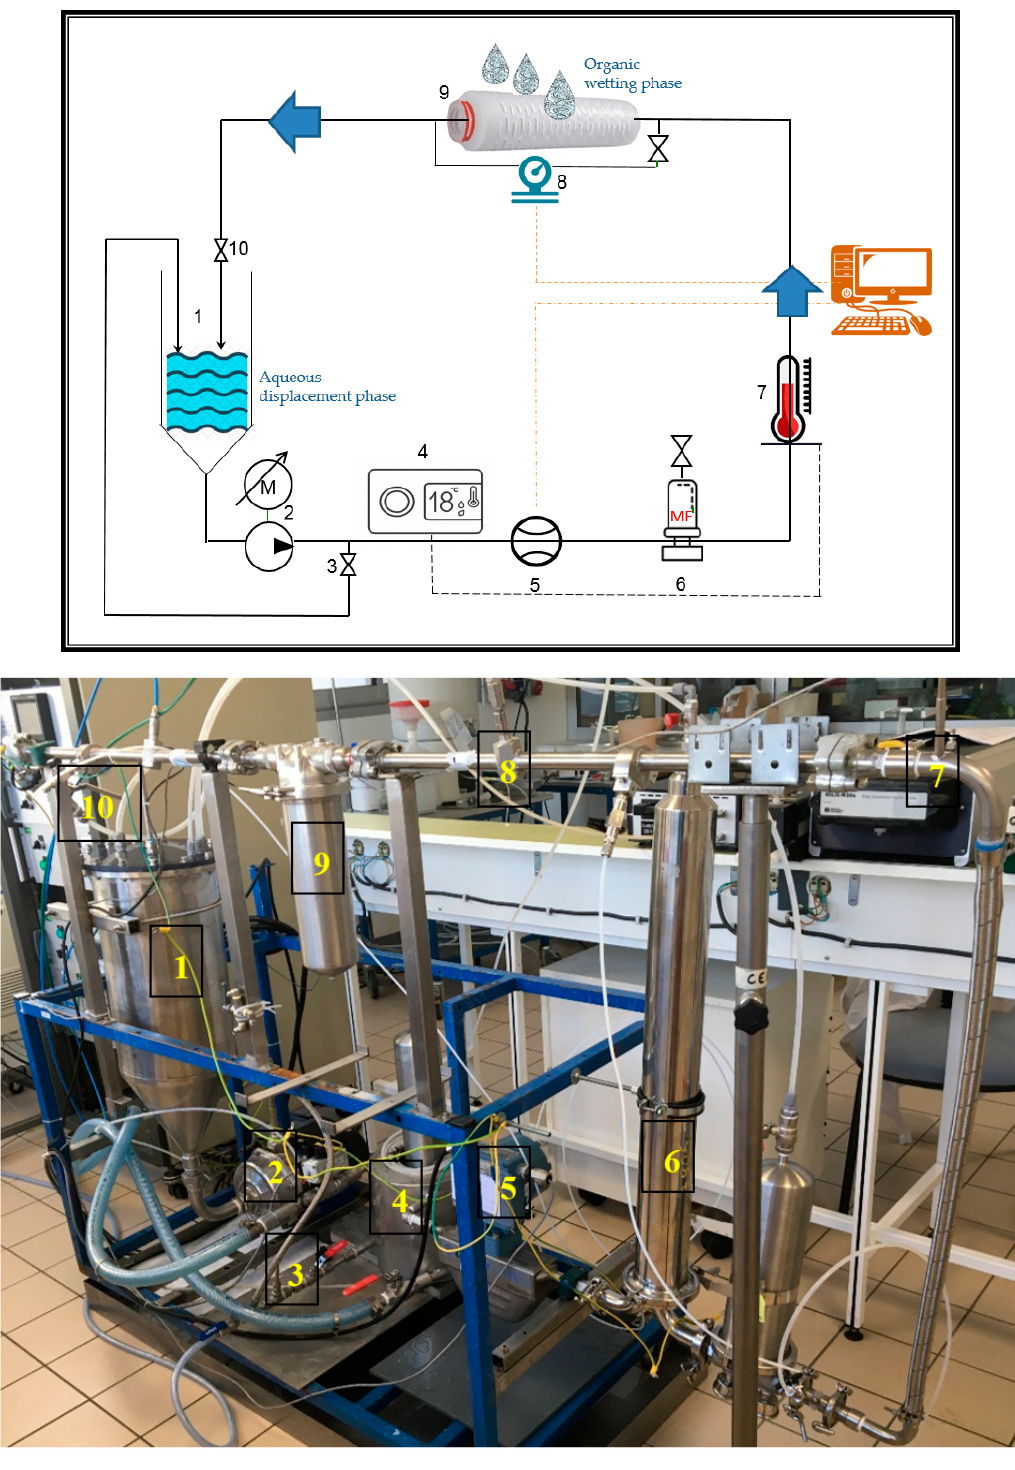
Figure 2. Scheme ( top ) and picture ( bottom ) of the LLDP porosimeter adapted for cartridges testing: 1 reservoir tank, 2 variable frequency pump, 3 bypass valve, 4 thermostatic regulator, 5 flowmeter, 6 pollution filter, 7 temperature sensor, 8 inlet manometer, 9 filter housing, 10 flow regulator valve.